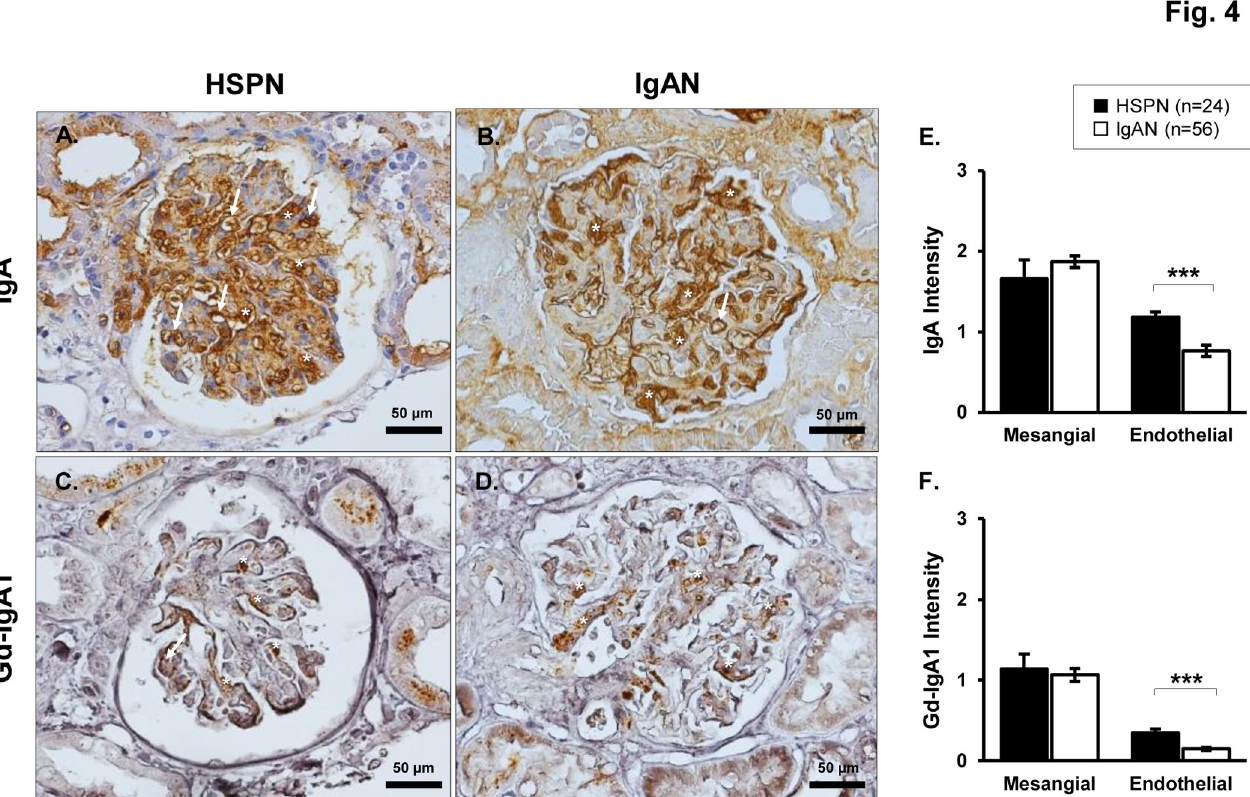
Fig 4. Distinction between glomerular IgA and Gd-IgA1 deposition identified by IHC staining in HSPN vs. IgAN. Consecutive paraffin-embedded sections, obtained form 24 patients with HSPN and 56 patients with IgAN, were stained with anti-human IgA polyclonal antibody and KM-55. Representative photos of IgA staining (brown reaction product) ( A and B ) and Gd-IgA1 (brown reaction product) staining ( C and D ). Endothelial positive areas are shown by white arrows, and mesangial positive areas were shown by white asterisks. Original magnification: × 40. Intensity of mesangial or endothelial IgA deposition among patients with HSPN or IgAN ( E ). Intensity of mesangial or endothelial Gd-IgA1 deposition among patients with HSPN or IgAN ( F ). Values are presented as the mean ± SEM. Data were statistically analyzed using Mann-Whitney U tests. ��� P <